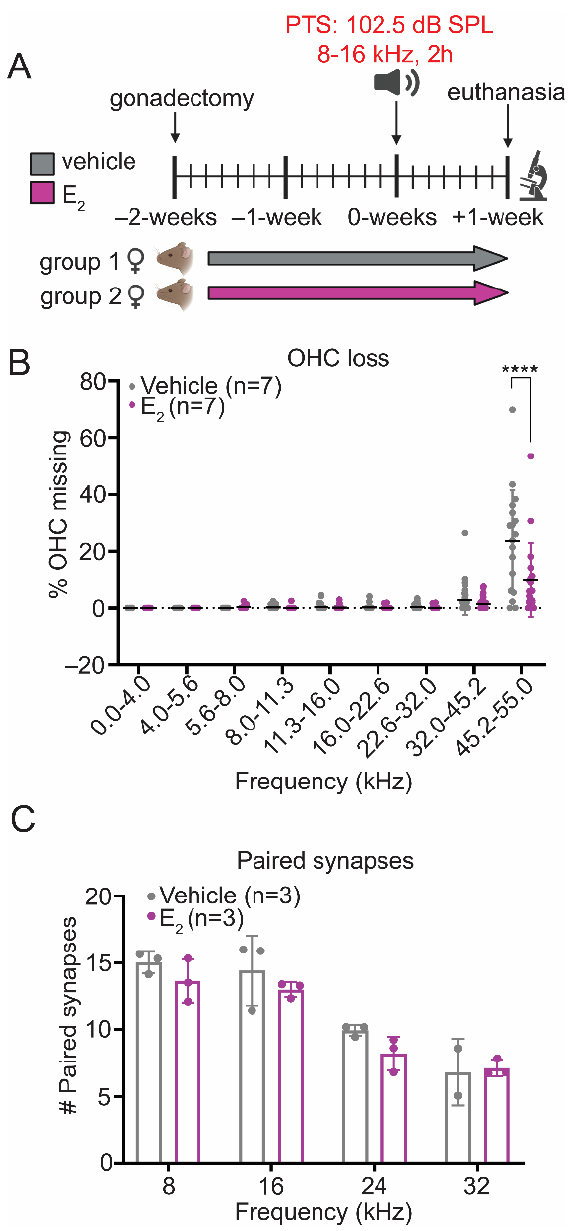
Figure 4. E 2 -replacement in female mice increases outer hair cell (OHC) survival in the base of the cochlea following a PTS-inducing noise exposure. ( A ) Experimental schematic. Female mice were gonadectomized at 8-weeks of age and treated with vehicle or E 2 (150 µ g/kg) beginning 2-days after the gonadectomy for the remaining duration of the study. Animals were euthanized for tissue collection 1-week post-exposure. ( B ) E 2 -replacement in female mice increases OHC survival in the base of the cochlea (45.2–55.0 kHz) 1-week following a PTS-inducing noise exposure ( p < 0.0001). ( C ) E 2 -replacement in female mice does not reduce the loss of paired IHC-ANF synapses 1-week following a PTS-inducing noise exposure. OHC survival and paired synapse number were compared between groups using a 2-way ANOVA followed by Sidak’s multiple comparison test. n = number of ears; plots: mean ± SD; **** p < 0.0001.